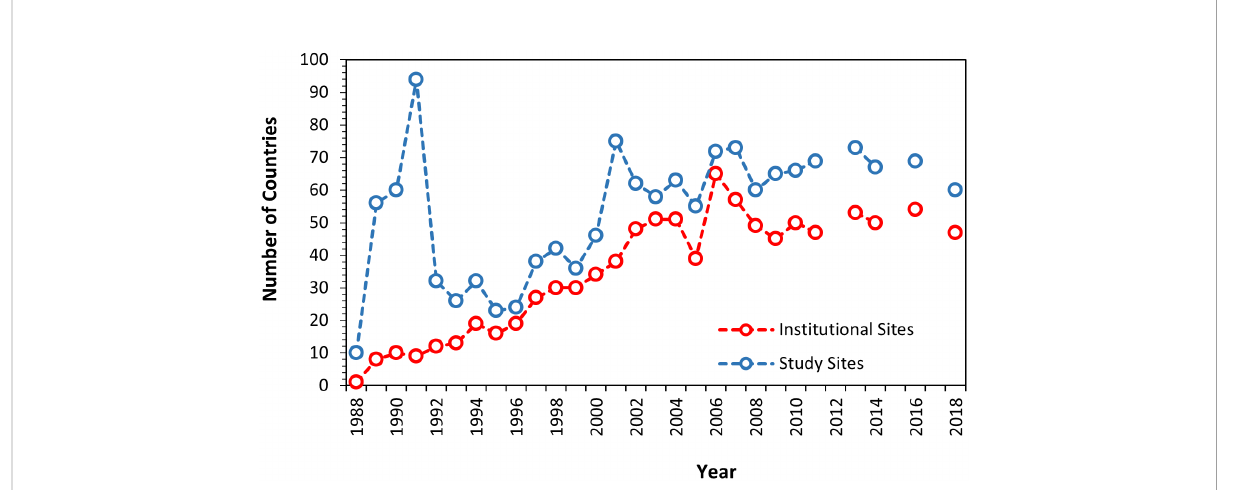
FIGURE 5 Number of abstracts (black), number of countries represented by institutional sites (red), and number of countries represented by study sites (blue) per year at the International Sea Turtle